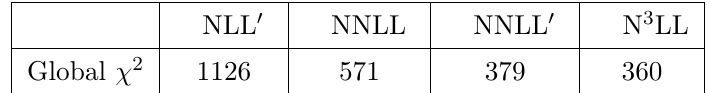
Figure 5 . The TMD of the down quark at (cid:22) = plot) as a function of the partonic transverse momentum k ? for three di(cid:11)erent values of x . The bands give the 1- (cid:27) uncertainty.